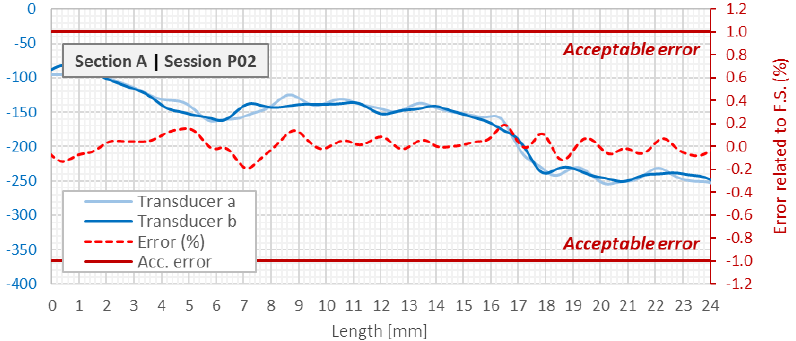
Figure 20. Reparability analysis between pressure transducer a and b during single measurement session P02 along section A .